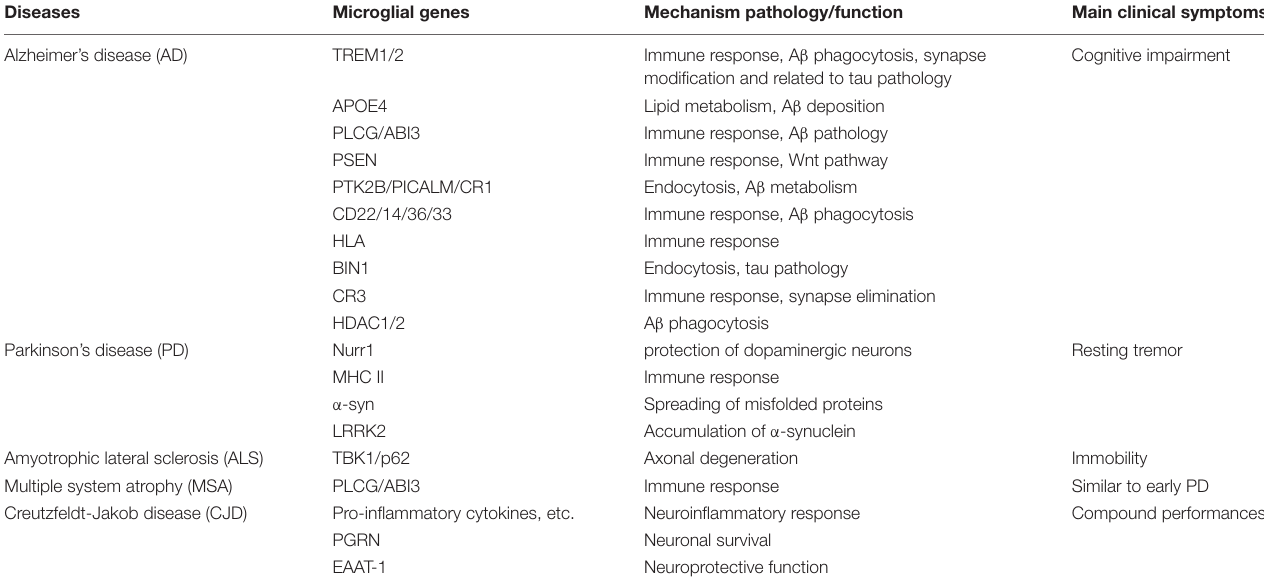
TABLE 1 | Microglial genes contributing to neurodegenerative